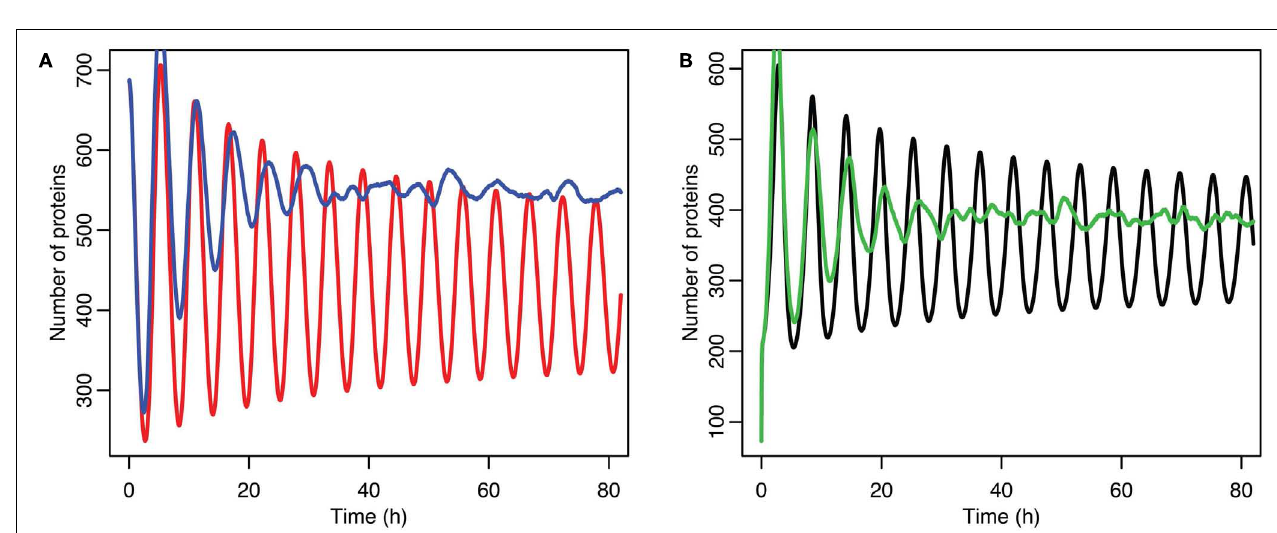
FIGURE 10 | Comparison of stochastic and deterministic models when p53 production is near the lower bifurcation point. (A) Shows the comparison for MDM2 with MDM2 from the deterministic model in red and